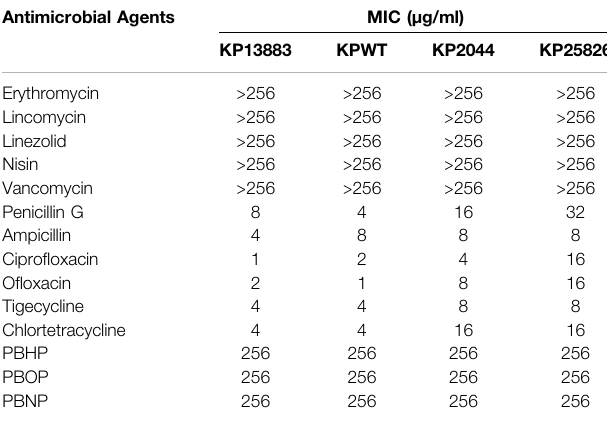
TABLE1| MICsof4 K.pneumonia strainstestedbydifferentantimicrobialagents. Antimicrobial